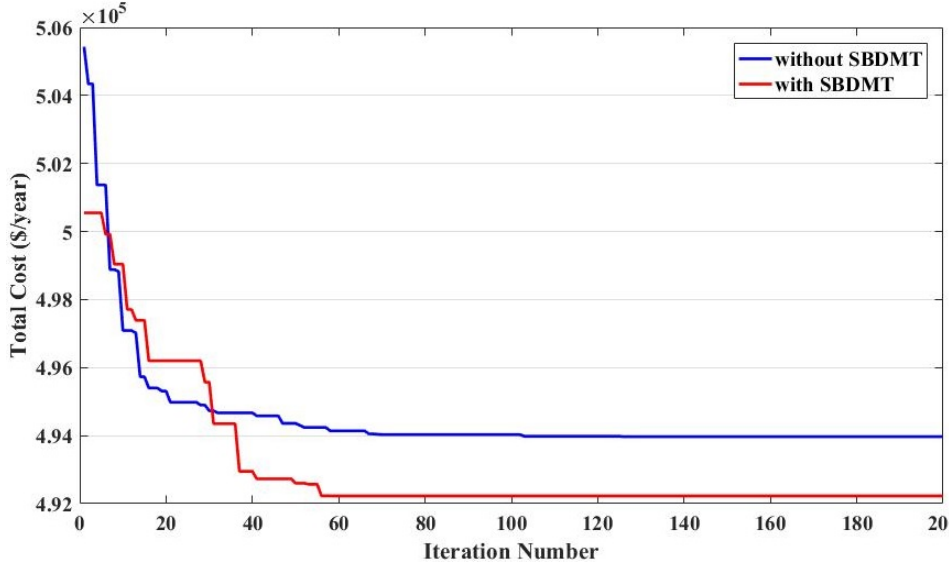
Figure 7. Convergence characteristics of PODESCA for the 118-bus system.